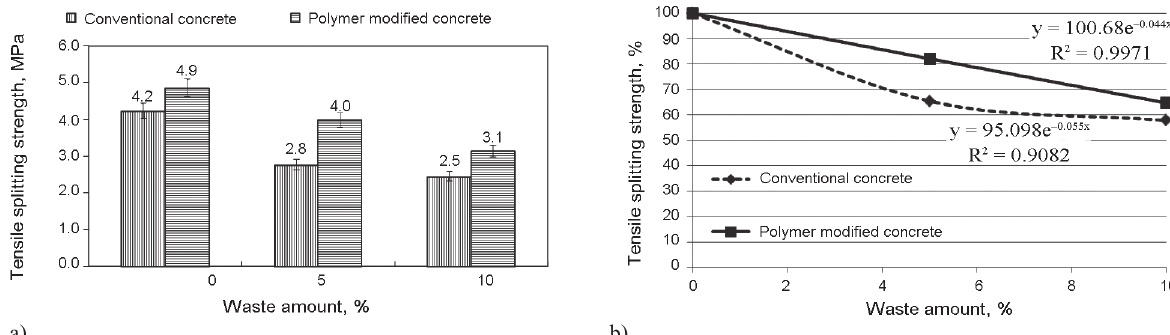
Fig. 6. influence of the amount of ecW on the tensile splitting strength of concrete samples in MPa (a) and in %